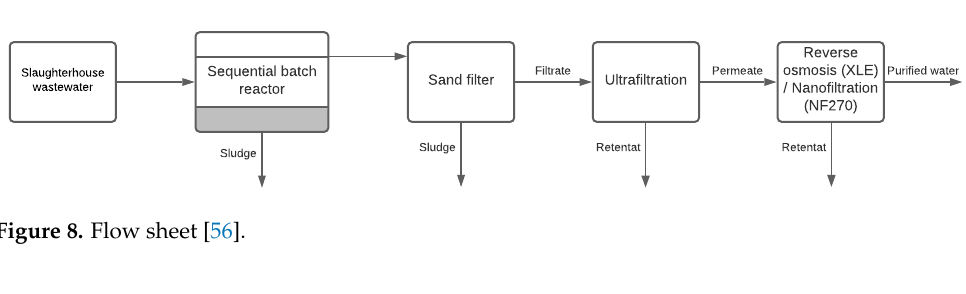
Figure 7. Flow sheet [55].